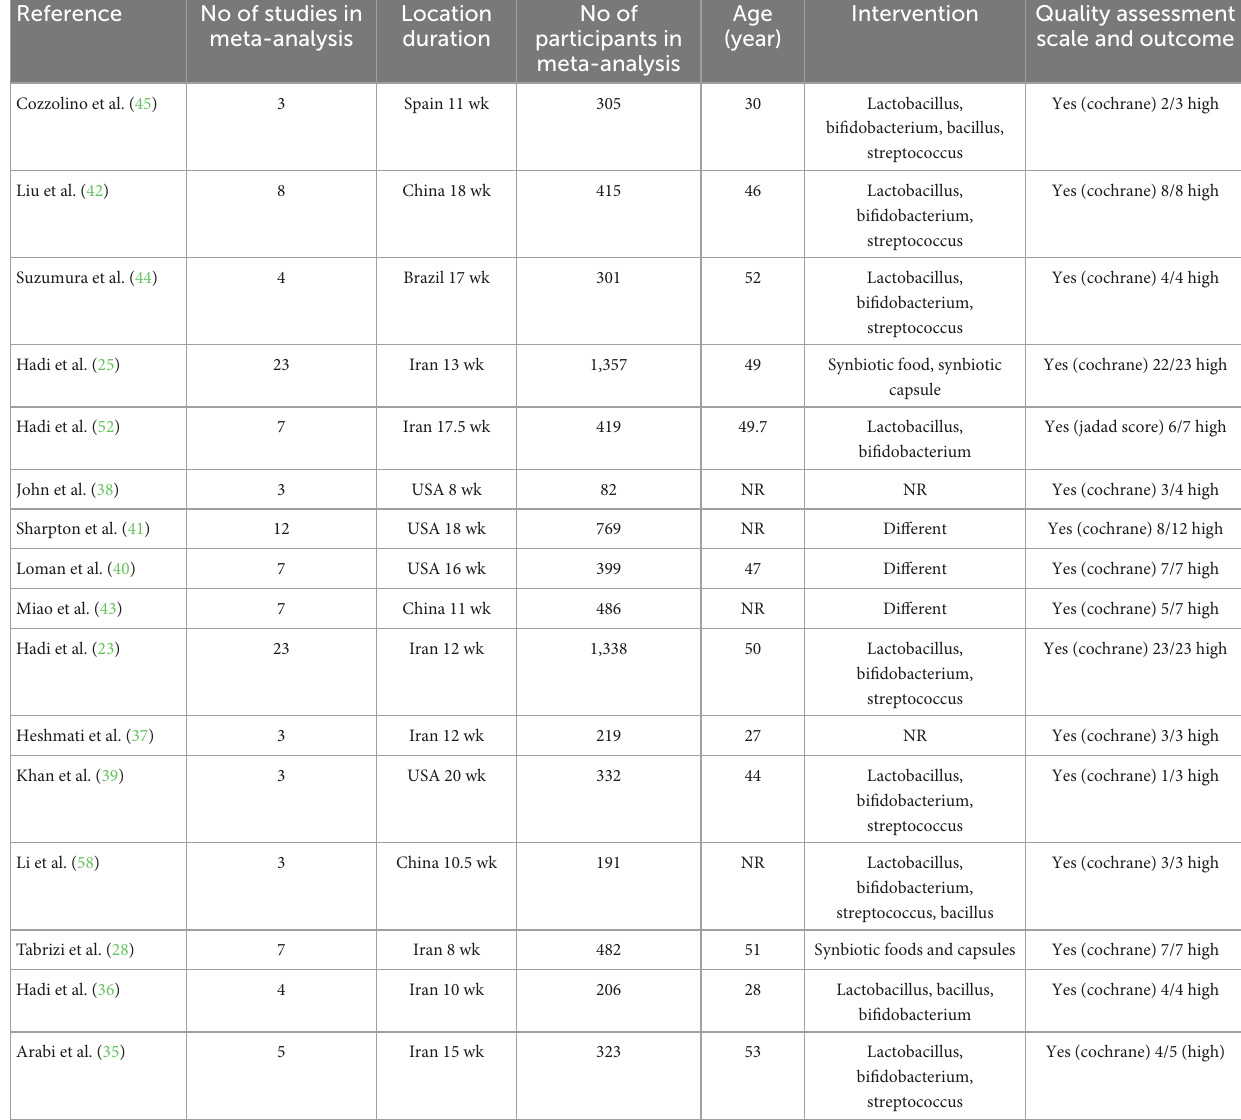
TABLE 1 Study characteristics of included